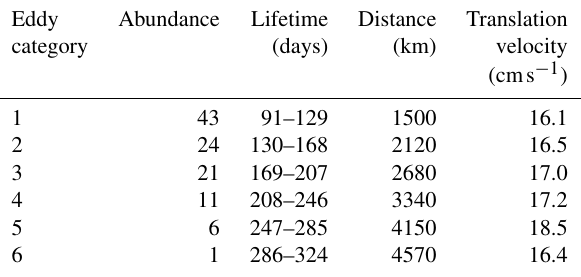
Table 1. Mean distance traveled, mean translation velocity, and number of long-lived ACEs per age class as shown in Fig. 7. Eddy Abundance Lifetime Distance Translation category (days) (km)